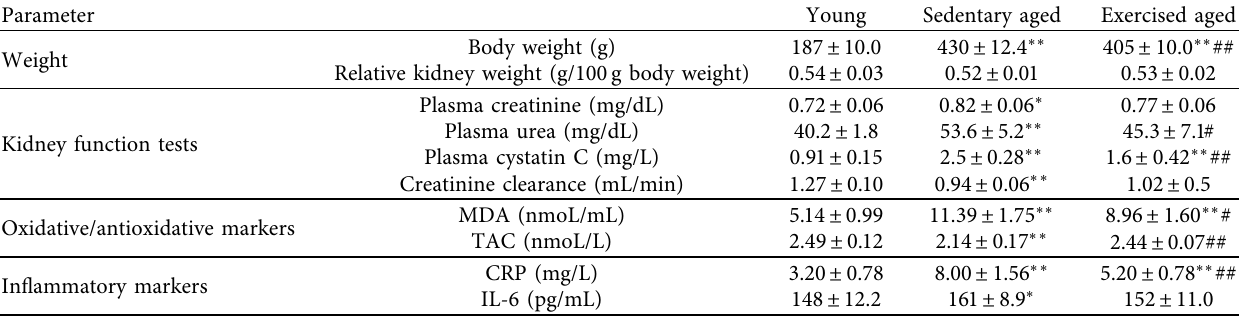
Table 1: Weight (body and kidney) and biochemical parameters of the different